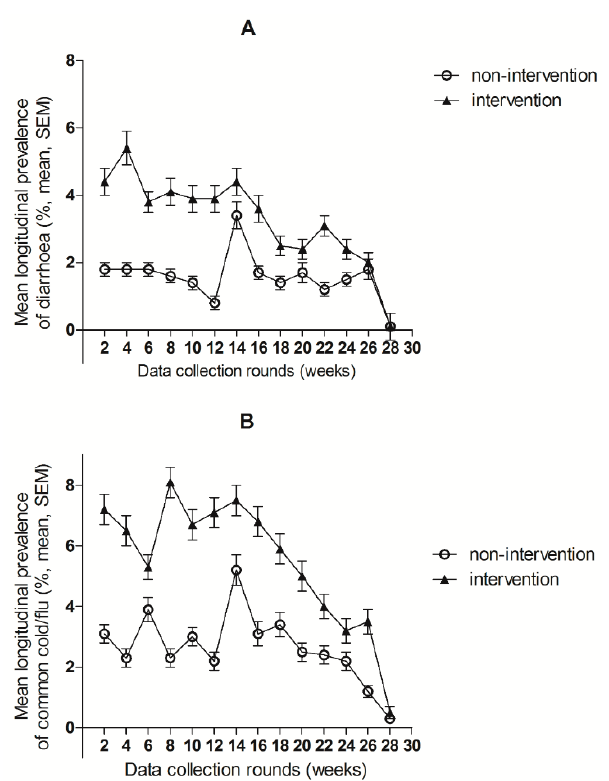
Figure 3. Mean longitudinal prevalence of diarrhoea ( A ) and common cold/flu ( B ) in intervention and non-intervention group over time at every 2 week measurement round. SEM = Standard Error of the Mean.